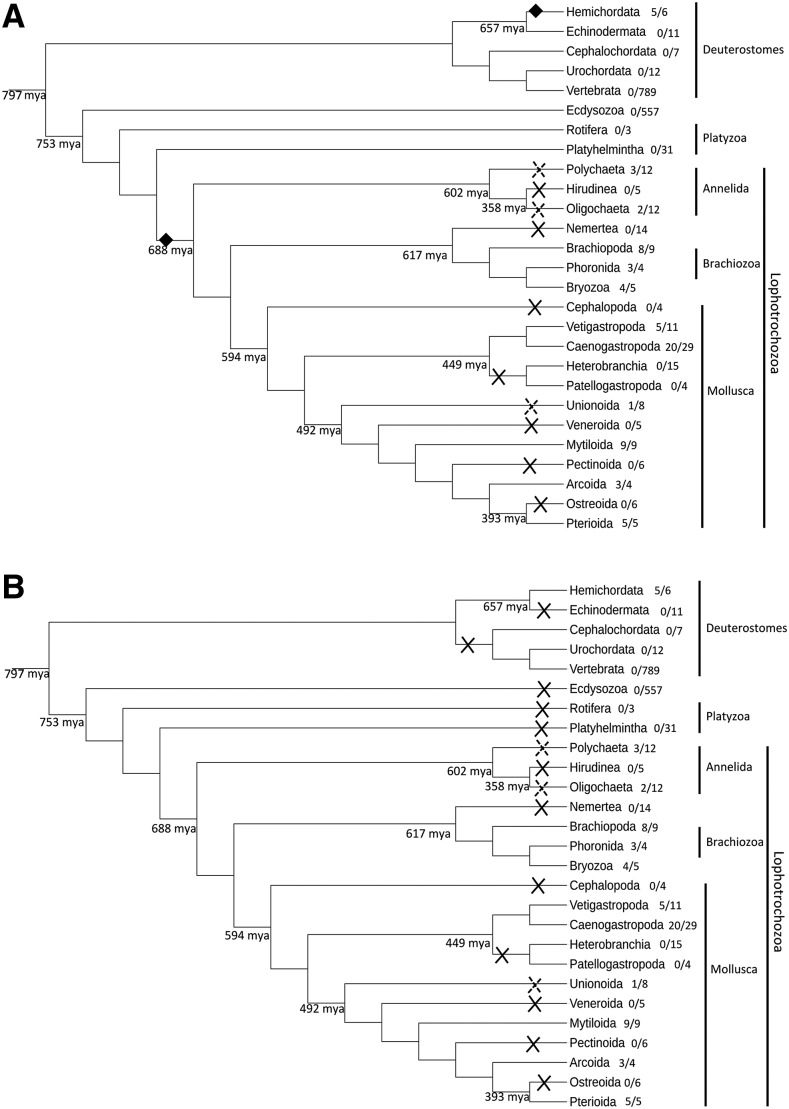
Two scenarii of HGT/gene losses of the GH13_1 genes. HGT or gene loss events were plotted on one of the proposed phylogenies of Bilateria, adapted from Plazzi et al. (2011); Kocot (2016); Kocot et al. (2017); Luo et al. (2015); Luo et al. (2018); Uribe et al. (2016). Fractions after the lineage names are the number of species showing GH13_1 sequences over the total number of species investigated. A: HGT hypothesis. Black diamonds represent the HGT events, crosses indicate subsequent GH13_1 loss events. B: Gene loss hypothesis. Crosses indicate GH13_1 loss events. Dashed crosses indicate lineages for which only a fraction of the available reliable genome or transcriptome data were found to contain a GH13_1 sequence. Divergence times are from Kumar et al. (2017).